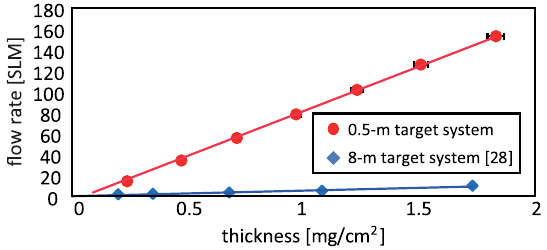
FIG. 3. Required flow rate as a function of the helium thick- ness for both 0.5- and 8-m target systems.